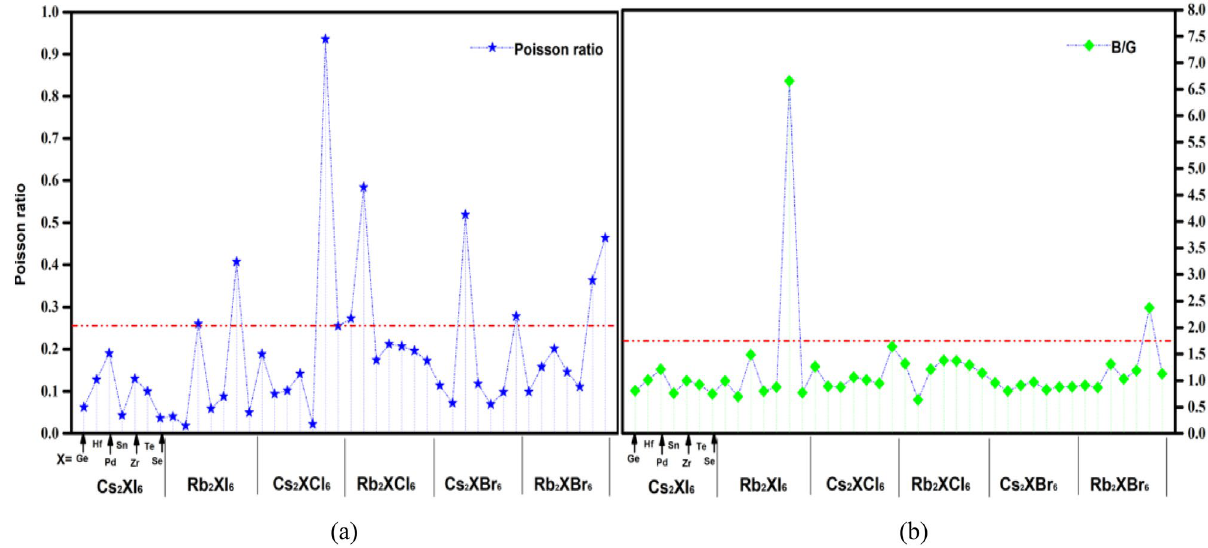
Figure 16. ( a ) Intuitive plot of Poisson’s ratio for 42 kinds of inorganic double perovskite materials, the figure shows that the Poisson ratio of Cs 2 TeCl 6 is the largest, ( b ) shows the B/G of Rb 2 TeI 6 is the 42 kinds of